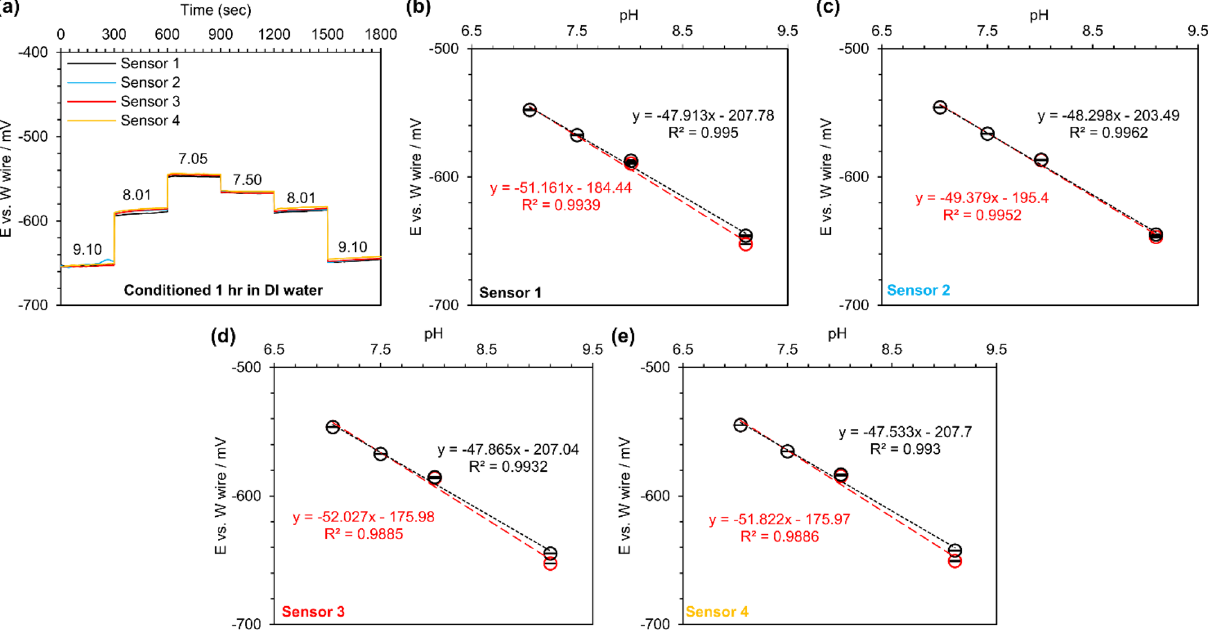
Figure 5. The pH sensitivity of tungsten wires and the custom-made reference electrodes for measuring pH in a narrower range: ( a ) Real-time response of 5-min bleached (NaClO) silver wires versus a tungsten wire in a different set of buffers with a narrower pH range after being conditioned for 1 h in DI water, ( b – e ) the calibration curves for each sensor. N = 4. Red colors show the decrease in pH, and the increase in pH is shown in black